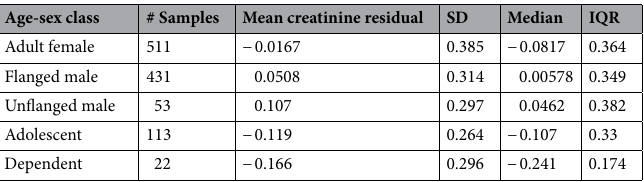
Table 2. Number of samples and summary statistics for each age-sex